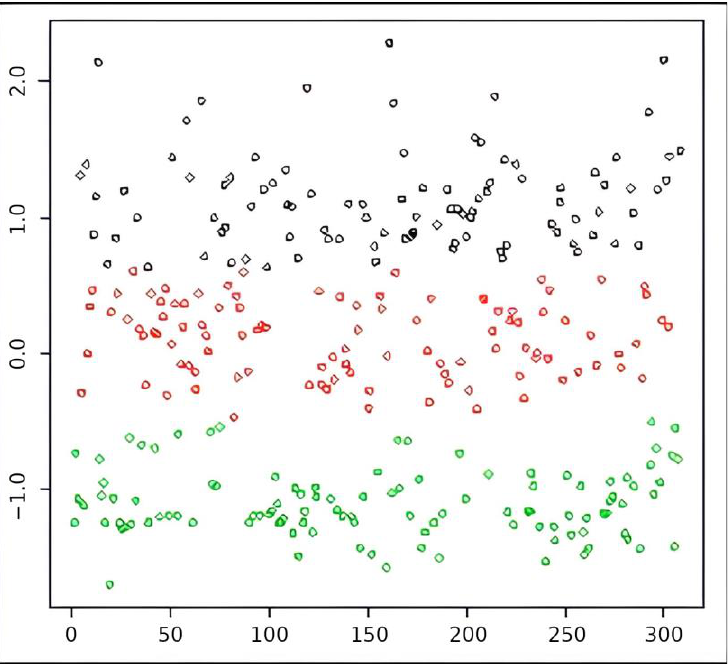
Figure 2. Sample grouping. Caption: G1 = black; G2 = red; G3 = green.